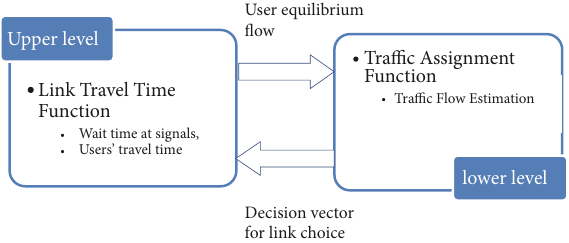
Figure 2: Bilevel model for traffic network determination